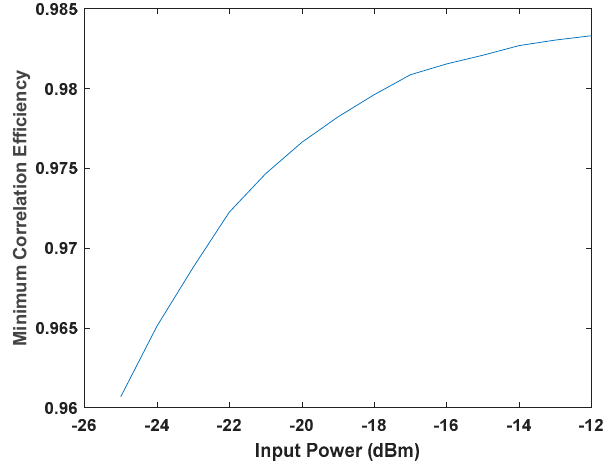
Figure 13. Minimum correlation efficiency measured at different input powers .